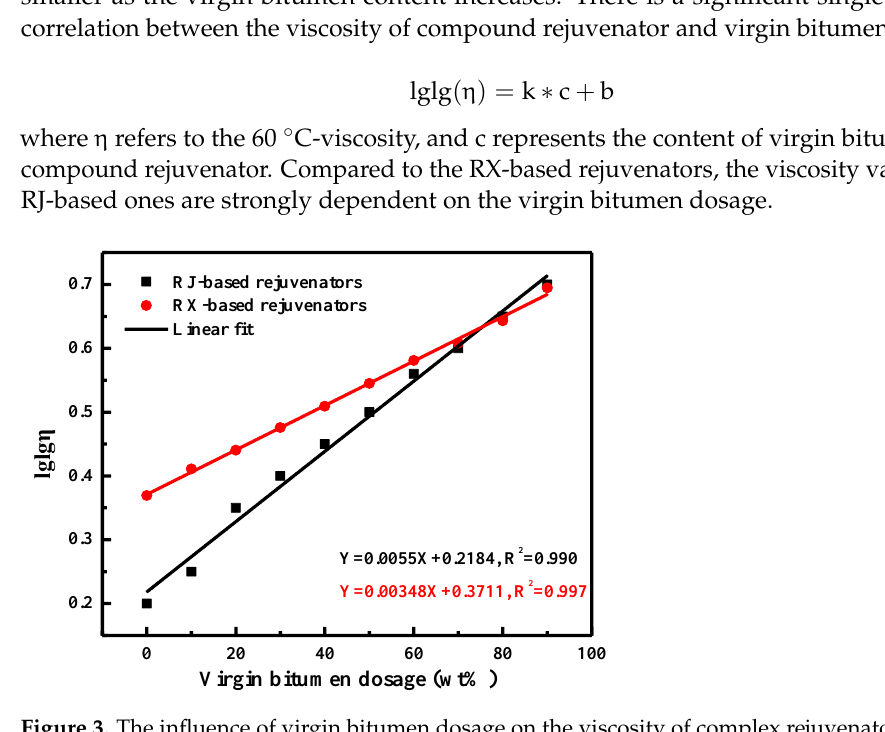
Figure 3. The influence of virgin bitumen dosage on the viscosity of complex rejuvenators.